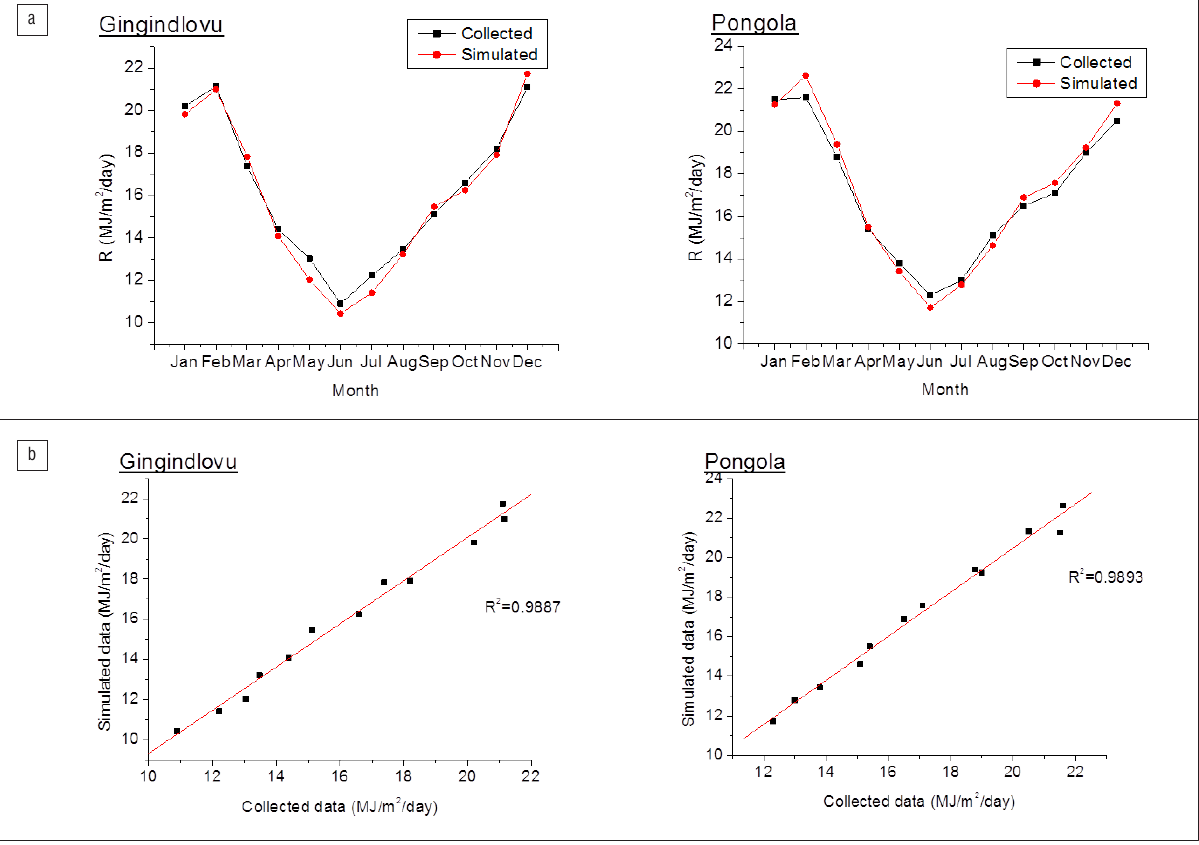
Figure 5: (a) Estimated radiation data for Gingindlovu and Pongola. (b) The fitted linear regression is shown together with the corresponding coefficient of determination ( R 2 ) for Gingindlovu and Pongola